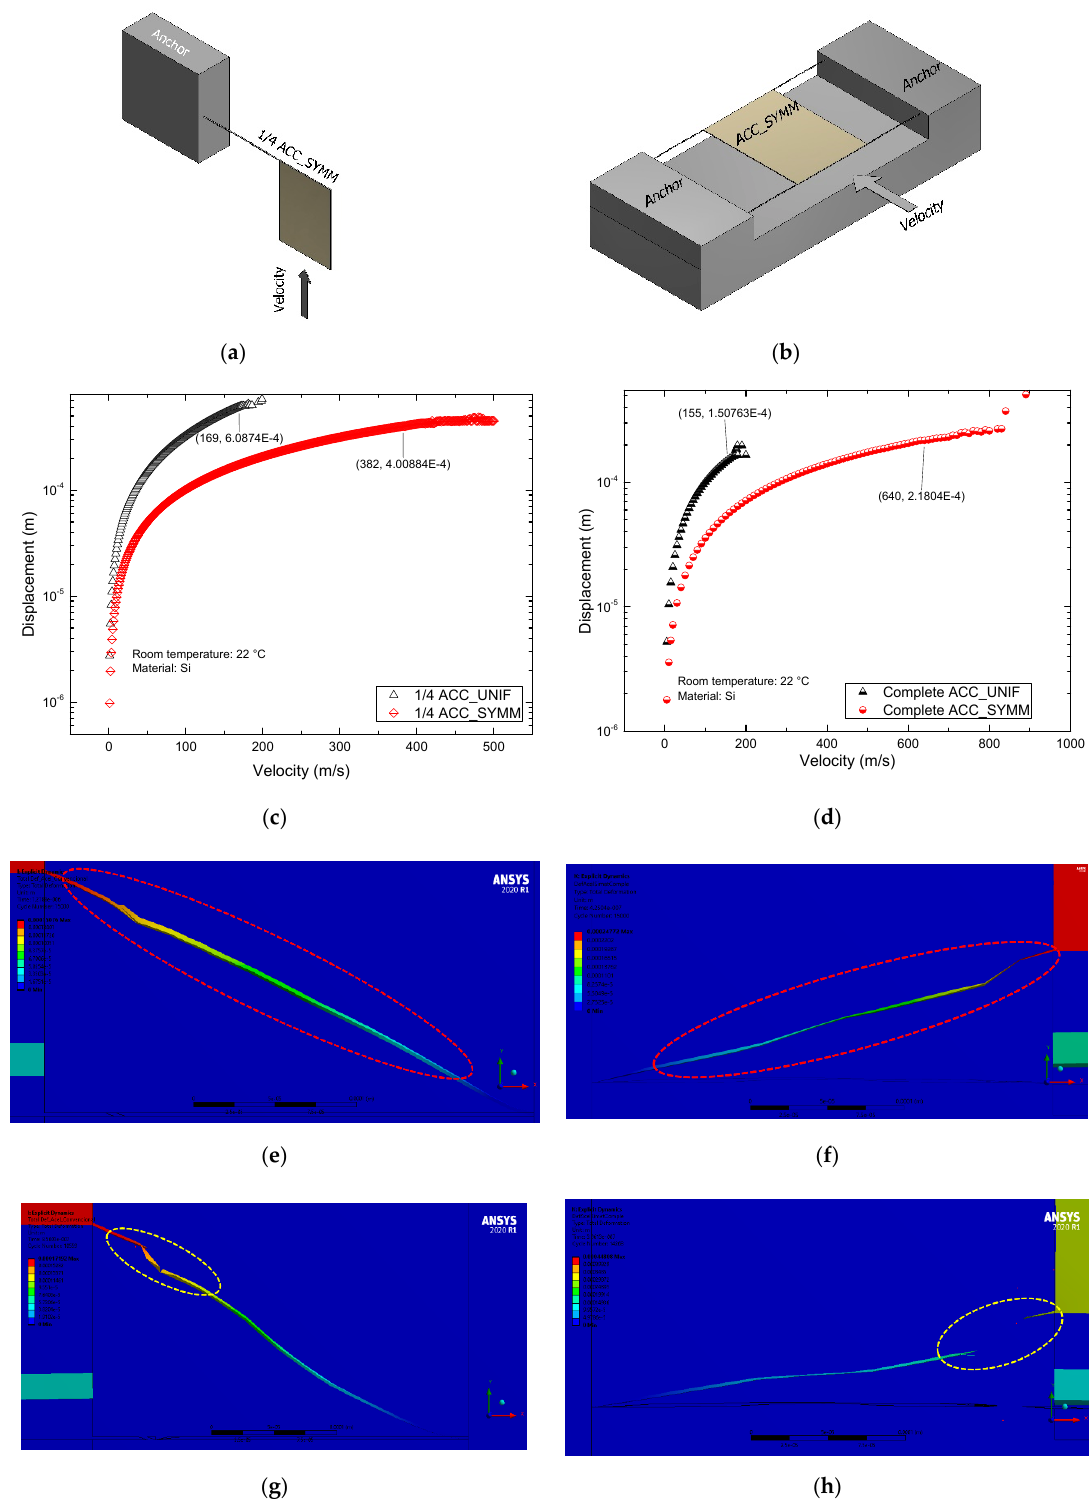
Figure 7. Explicit dynamic analysis. Velocity applied to ( a ) ¼ of ACC_SYMM, 3D view. ( b ) Complete ACC_SYMM, 3D view. Displacement of ( c ) ¼ of ACC_SYMM and ¼ of ACC_UNIF, ( d ) Complete ACC_SYMM and Complete ACC_UNIF. Performance with velocity load at ( e ) 155 m/s for Complete ACC_UNIF, and ( f ) 640 m/s for Complete ACC_SYMM. Performance of ( g ) complete ACC_UNIF at 250 m/s and ( h ) Complete ACC_SYMM at 1 km/s.